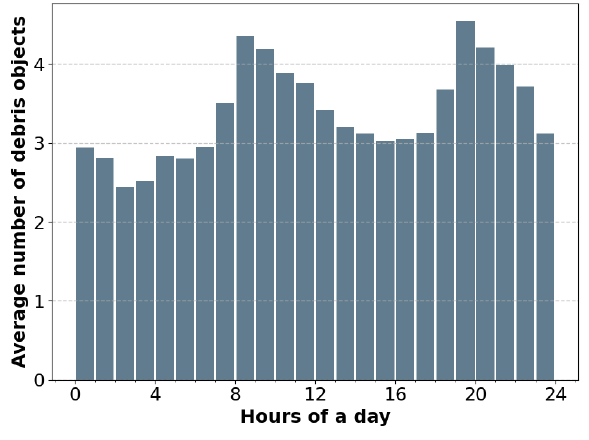
Figure 4. Maximum simultaneous number of trackable targets during a 24 h